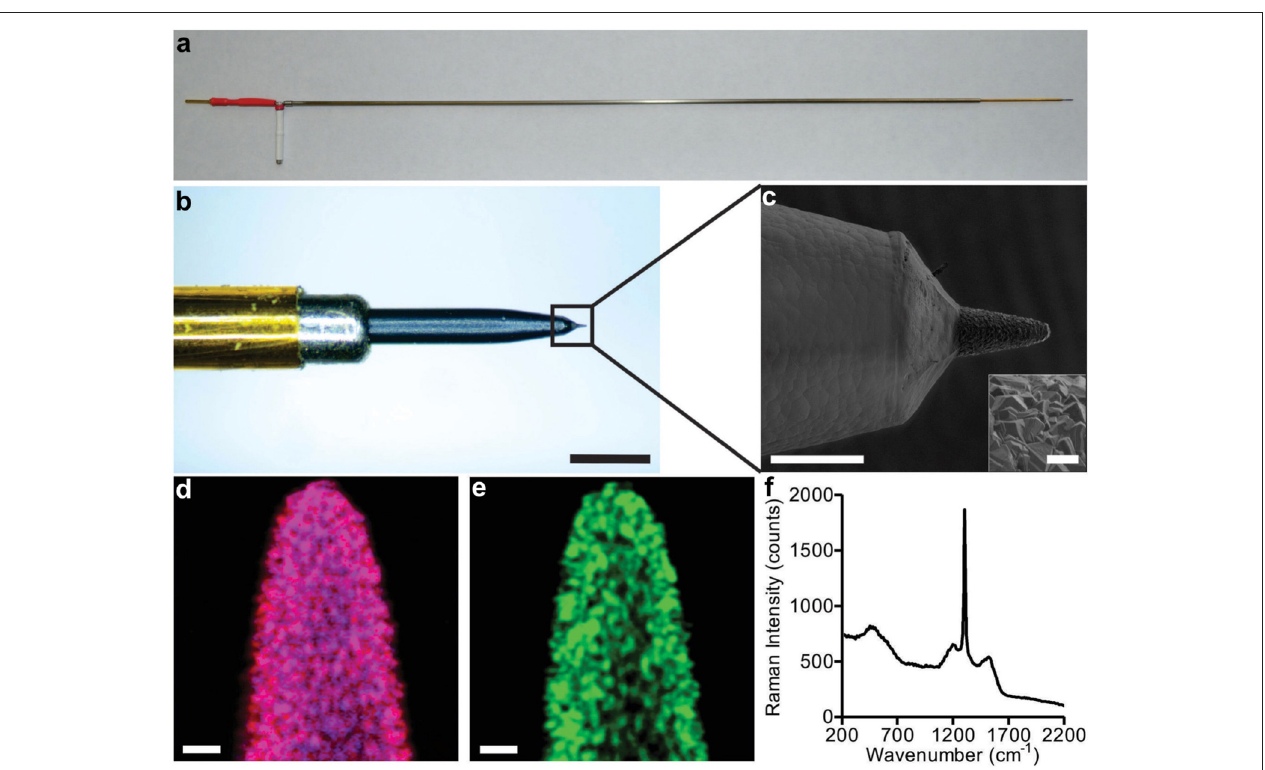
FIGURE 1 | Diamond FSCV probe construction. Panel (A) depicts the overall full length electrode suitable for acute large animal and human recordings. The scale bar is 25mm. Panel (B) shows a detailed optical magnification of the tip and its individual components, scale bar is 500 µ m. Panel (C) is an SEM image, showing the transition from the parylene insulation to the diamond sensing tip, scale bar is 100 µ m (crystal detail scale bar is 10 µ m). Panels (D,E) show Raman spectral maps of the probe depicted in panel (C) , scale bar is 10 µ m. The three color channels assigned to material constituents are: blue for boron doped diamond, red for diamond, and green for carbon sp 2 impurities. Magenta color observed in image (D) is a combination of blue and red. Panel (F) shows the integrated Raman spectrum of Raman images in panels (D,E) . The Raman measurements were acquired with a 532nm excitation